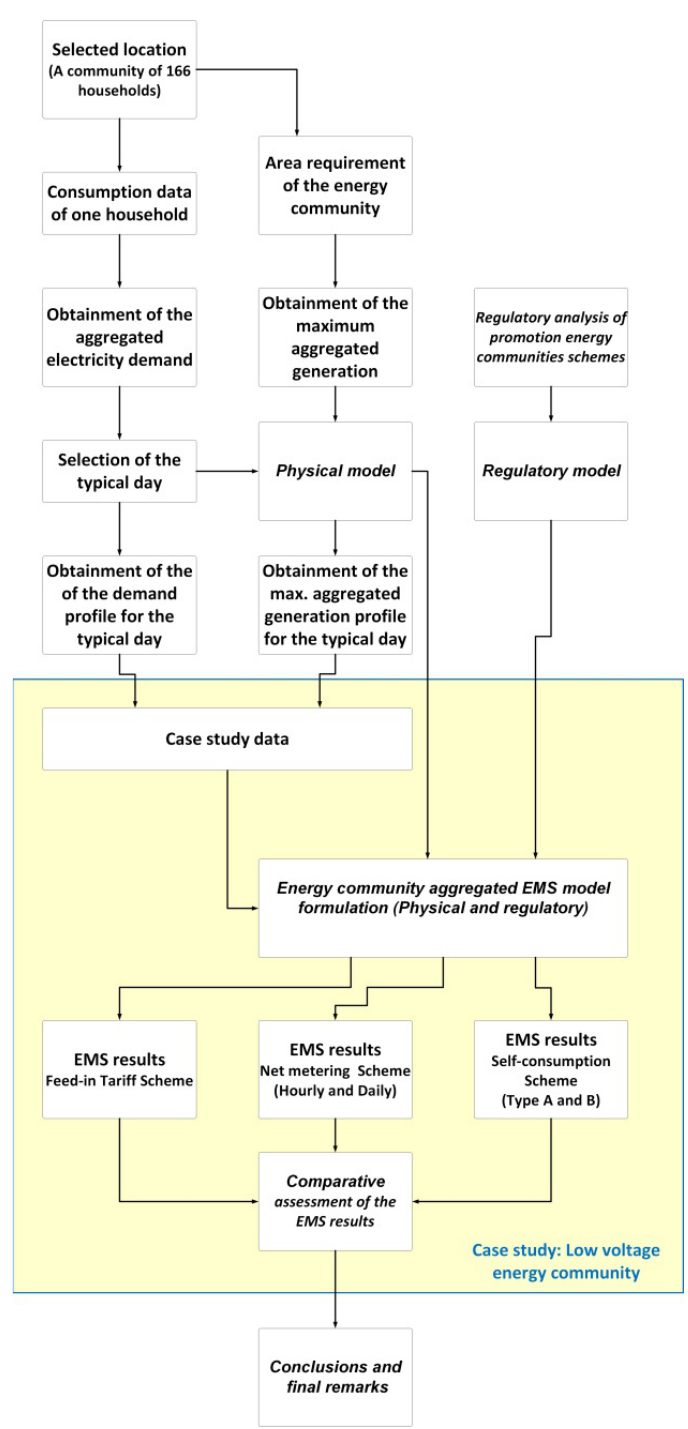
Figure 1. Methodology employed in this article. Source: self-elaboration.